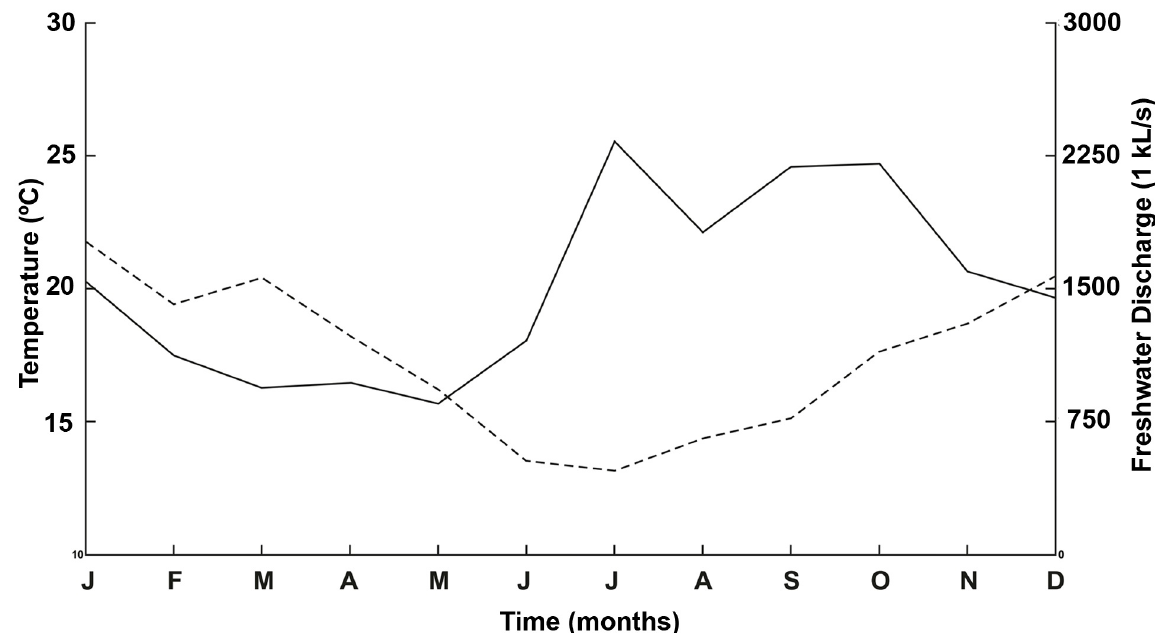
Figure 1. Monthly means (grouped months) profiles of air temperatures (dashed line) and fluvial discharge (rainfall average estimates; straight line) obtained between January 2009 and August 2016 in the study